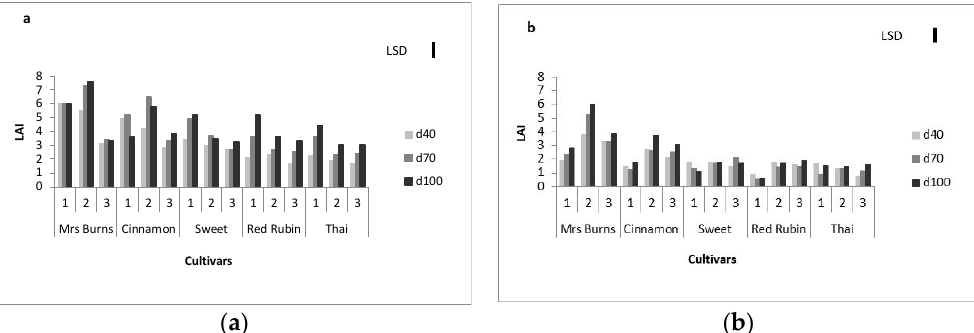
Figure 1. Leaf area index (LAI) of the five basil cultivars during the three growing stages (where 1 is for the initiation of flowering, 2 is for the full bloom, 3 is the end of flowering) at the three irrigation levels (d 40 , d 70 , and d 100 ) for the two growing seasons 2015 ( a ) and 2016 ( b ). Data presented are mean values; vertical bar corresponds to the least significant difference (LSD).